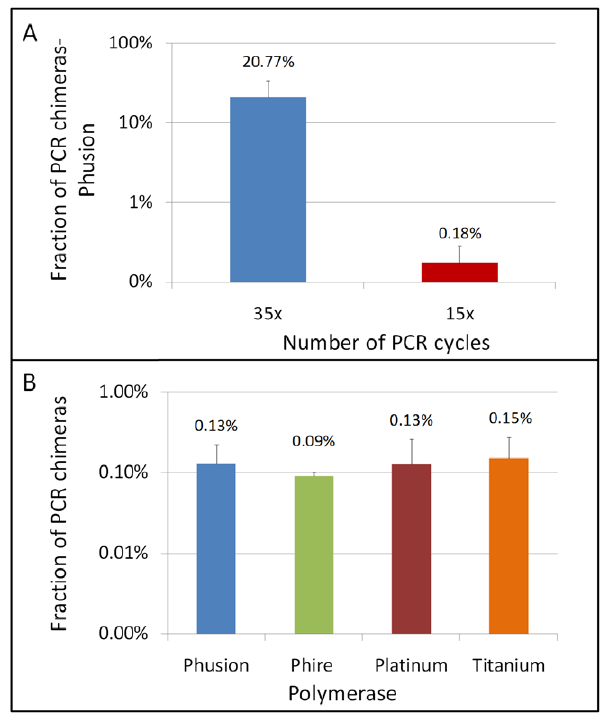
Figure 4. Assessment of chimeras formed during PCR. A. Comparison of the fraction of false recombinants measured in 400– 2200 bp templates amplified with Phusion polymerase using either 35 or 15 PCR cycles. The fractions are averages estimated from at least 5 independent experiments using different template lengths (error bars are the estimated standard deviation). B. Fraction of false recombinants measured in 422 base pair PCR products amplified for 15 cycles by different polymerases. The fractions are averages estimated from three independent experiments and error bars are the estimated standard